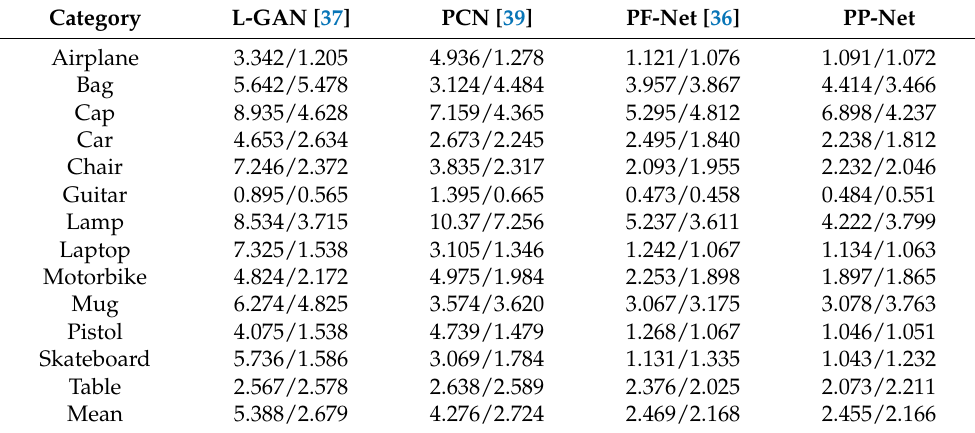
Table 3. Point cloud completion results of missing areas. The training data comprise 13 different types of objects. The numbers displayed from left to right are Pred → GT/GT → Pred error, which are all multiplied by 1000. The last line represents the overall average error.